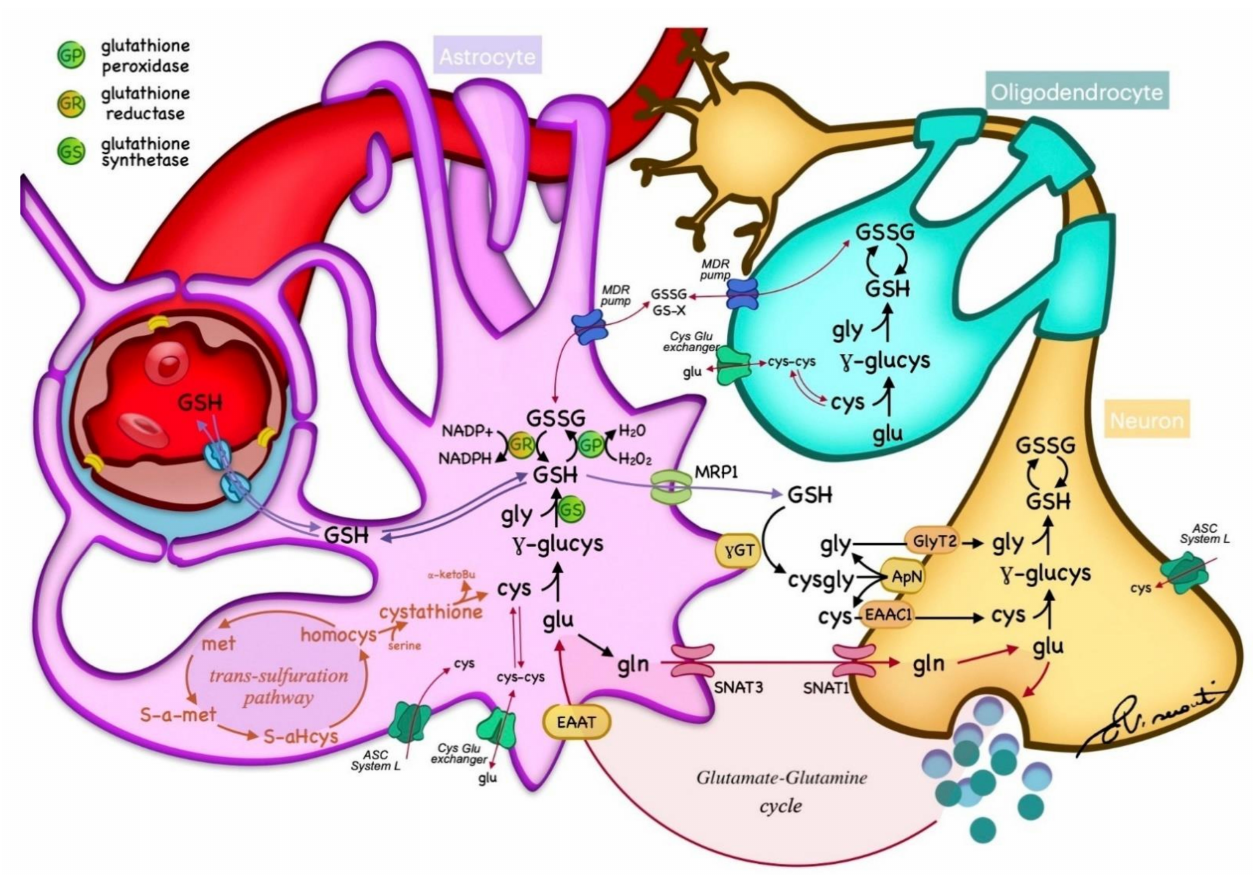
Figure 1. Glutathione (GSH) metabolism within the nervous tissue. GSH is synthesized in the cytoplasm of neurons and glia from essential amino acids, and catabolized through hydrolysis in the cell membranes. GSH acts as a reducing agent by donating an electron to H 2 O 2 , leading to the formation of H 2 O, O 2 , and glutathione disulfide (GSSG), which is regenerated by glutathione reductase (GR) from NADPH. The transportation of GSH and essential metabolites is regulated by different transporters across cell membranes. Cys—cysteine; glu—glutamate; gln—glycine; met—methionine; homocys—homocysteine; MPR—multidrug resistance pump; γ GT— γ -glutamyltransferase; γ -glucys— γ -glutamylcysteine; EAAT—excitatory amino acid transporter; SNAT—sodium-coupled neutral amino acid transporter; ASC—alanine, serine, and cysteine transport